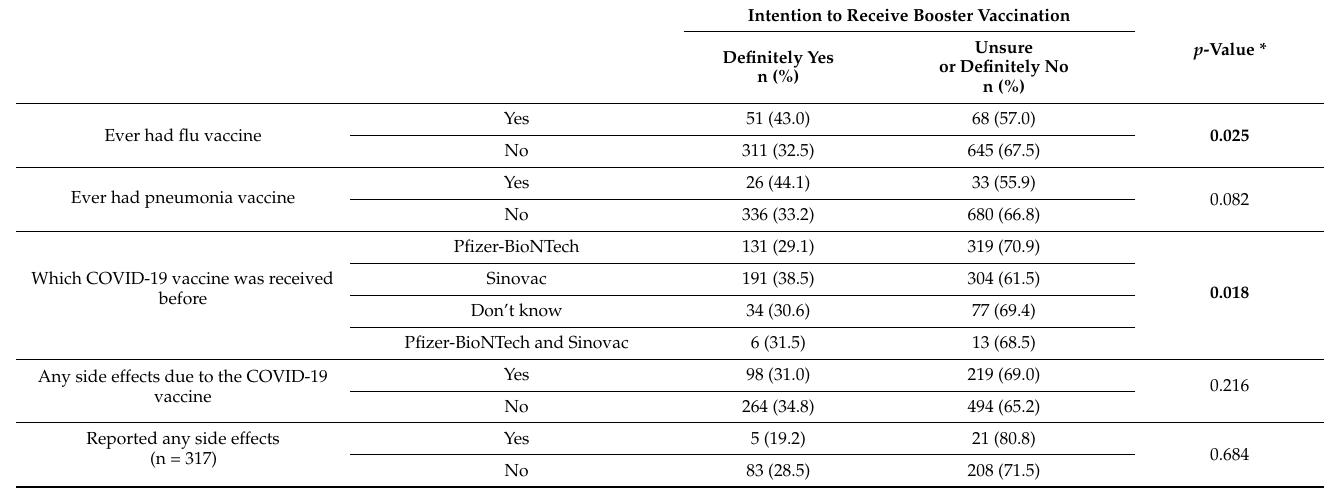
Table 3. Characteristics of participants related to other vaccines by intention to receive the booster